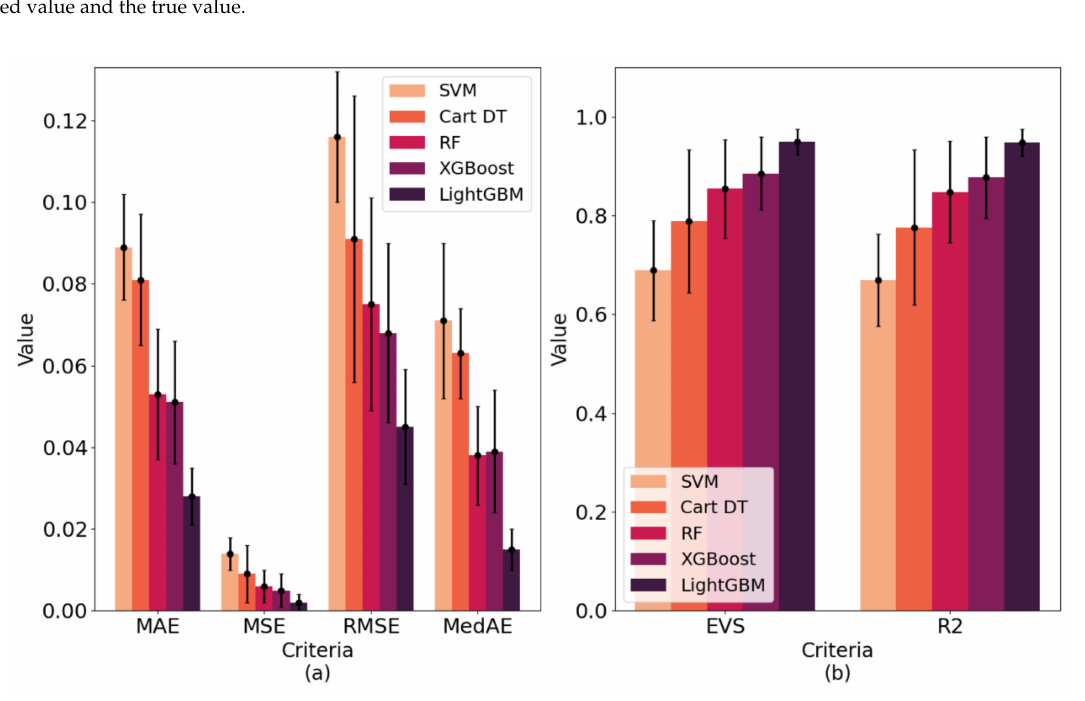
Figure 14. Prediction performances of five machine learning models by 10-fold cross-validation under different evaluation criteria: ( a ) The lower the criteria value, the better the model performance; ( b ) The higher the criteria value, the better the model performance. The data types presented in ( a , b ) are the results of the 10-fold cross-validation under each regression indicators in Table 4. The length of the histogram represents the mean of the cross-validation, and the error bars represent the standard